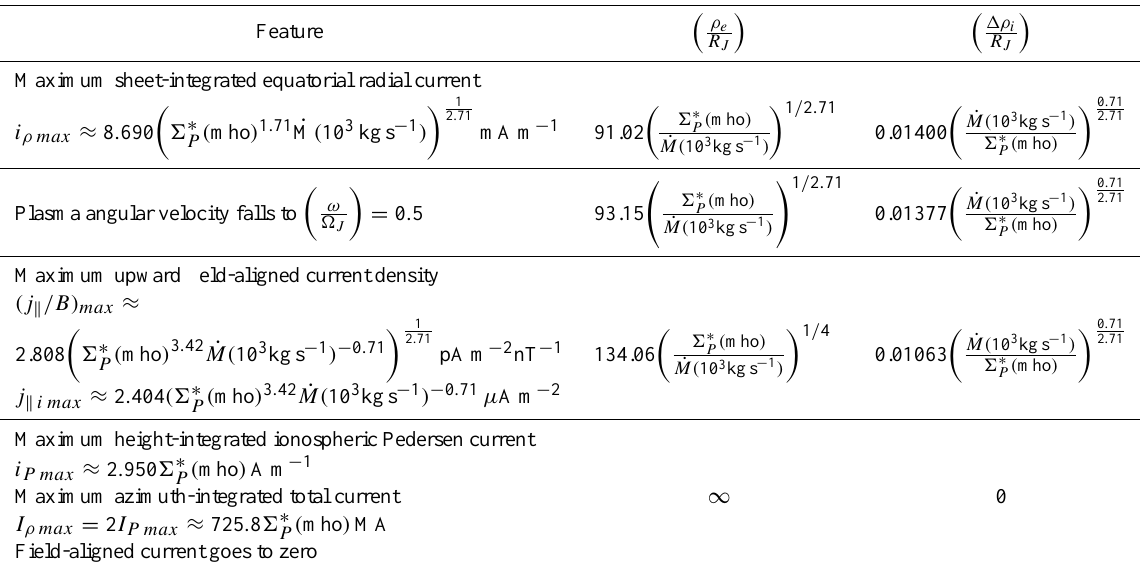
Table 4. Principal features of the plasma angular velocity and coupling current system for the power law current sheet field in physical